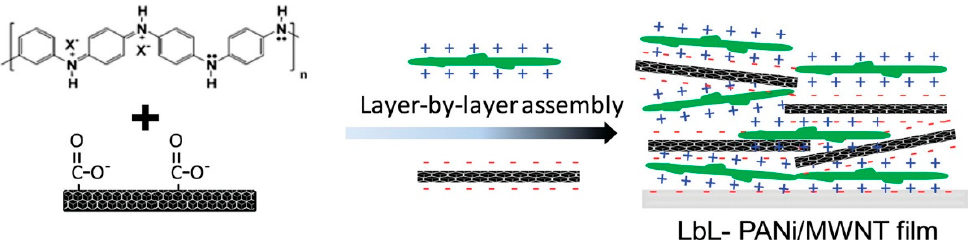
Figure 6. Sketch of the assembly process of LbL multilayers obtained by the alternate deposition of polyaniline with positive charges and MWCNT modified with carboxylic groups. Reprinted with permission from Ref. [113] . Copyright 2011 American Chemical Society.